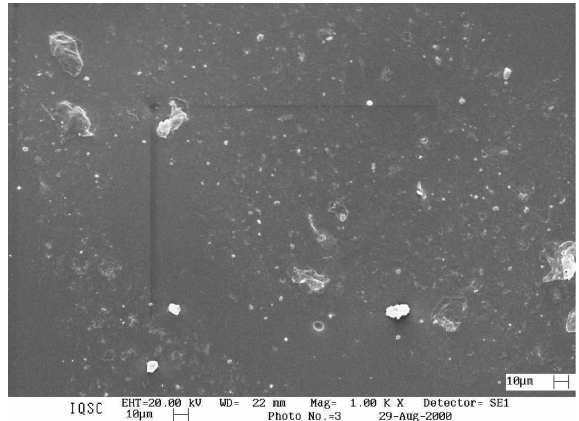
Figure 8. SEM micrograph of amylopectin-rich stanch grafted with toluene poly(propylene oxide) diisocyanate (1000x).